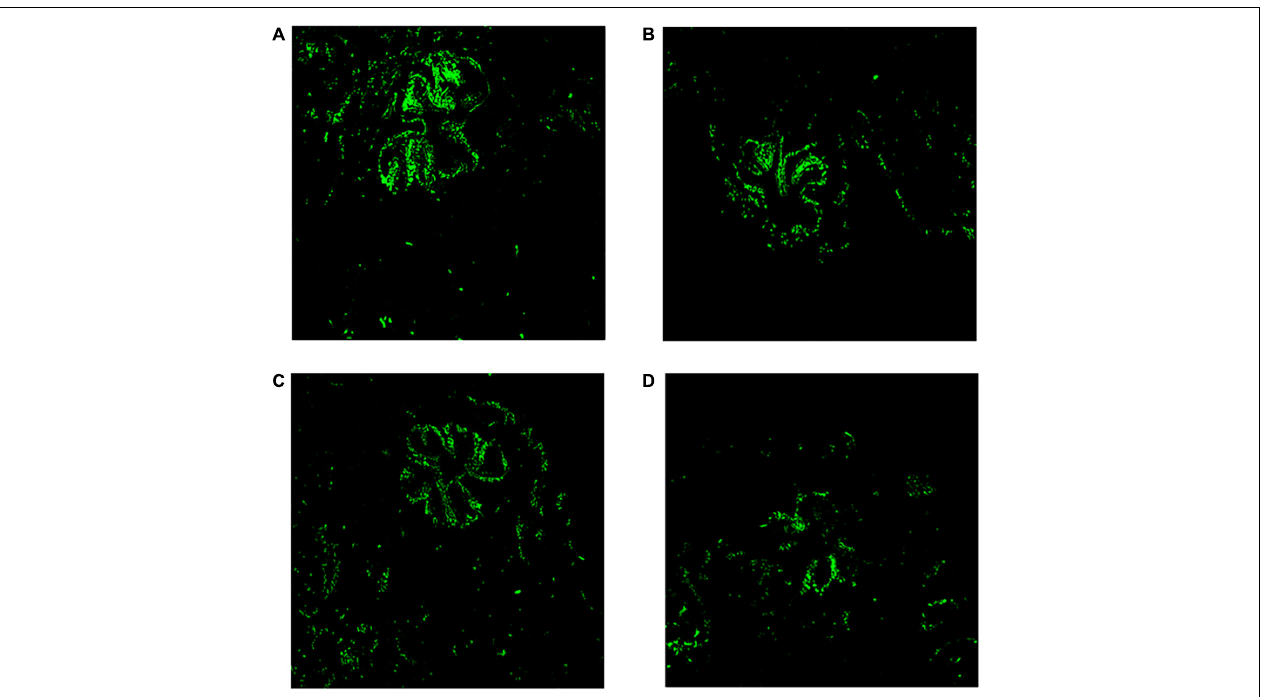
FIGURE 3 | Microcosmic analysis of corals after MPs exposure for 96 h. Fluorescence analysis of chlorophyll in coral tissue (20 × ). (A) Control, (B) PET, (C) PA66, and (D) PE.